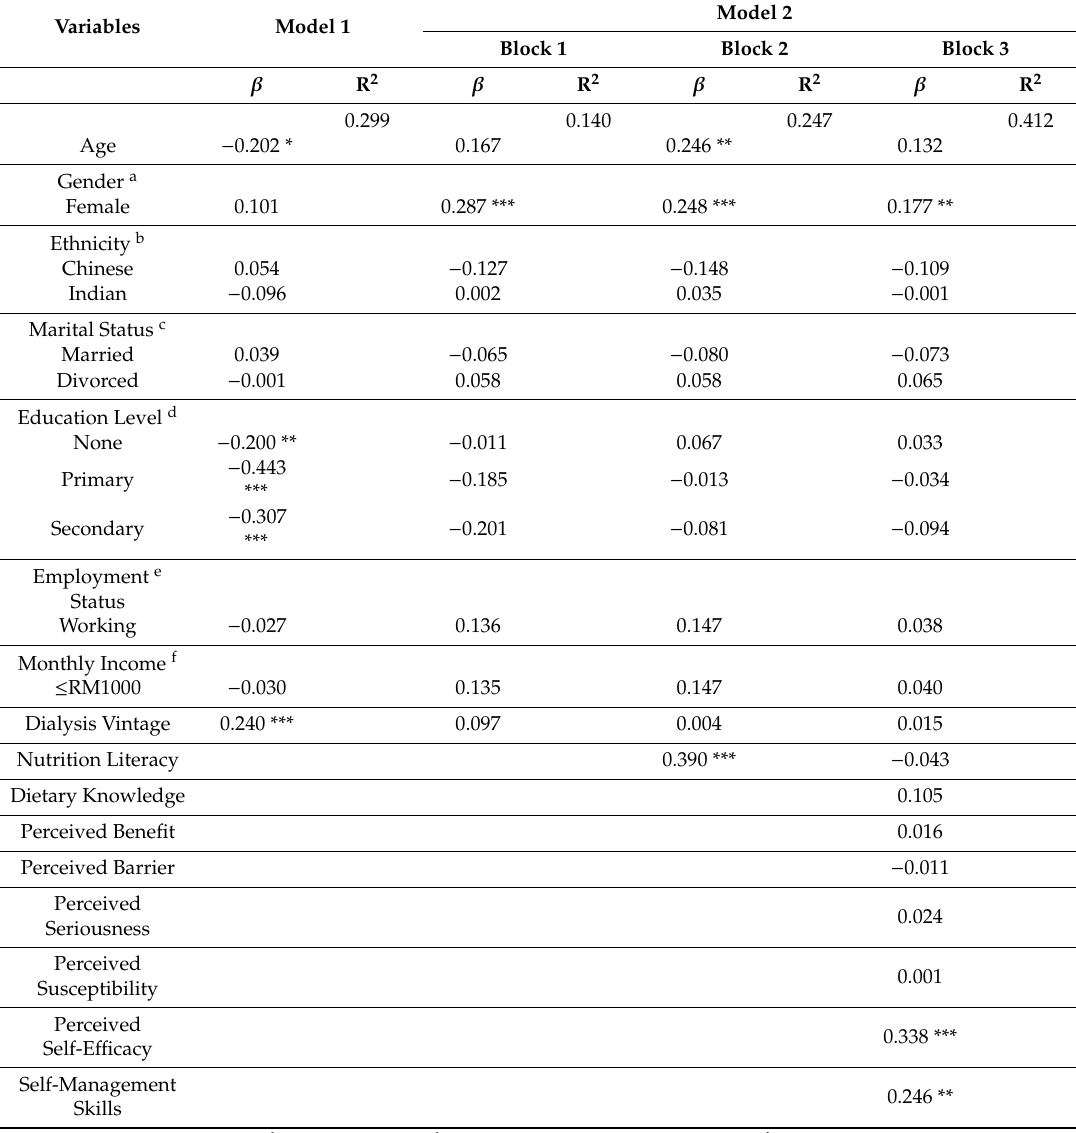
Table 3. Predictors of Nutrition Literacy and Dietary Adherence in HD Patients ( n =